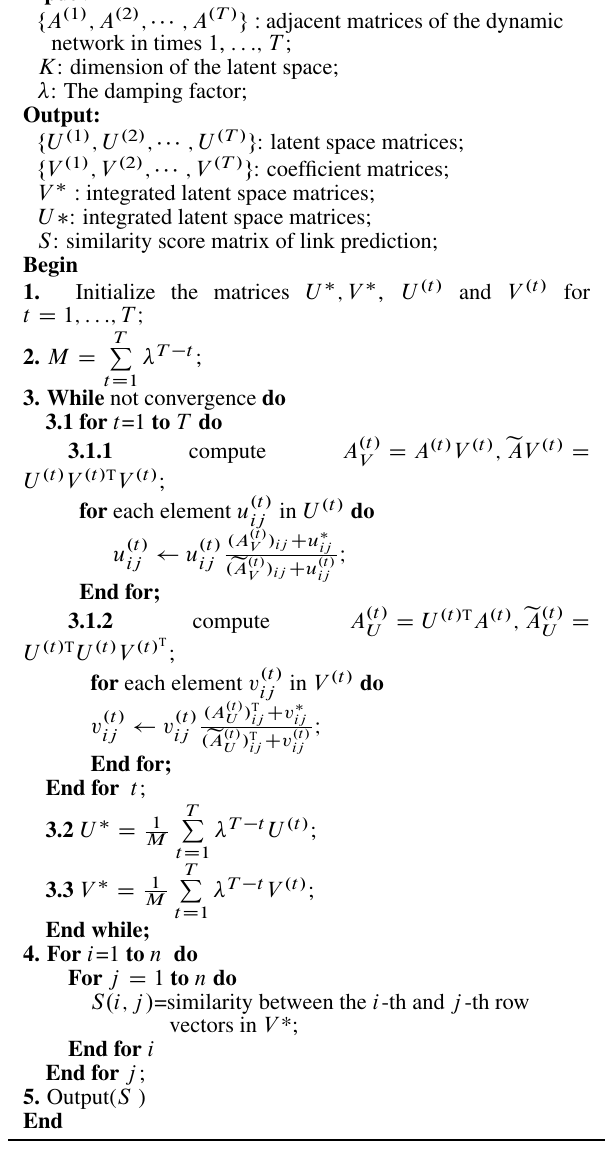
Algorithm 1 MF (NMF based Link Prediction) Input